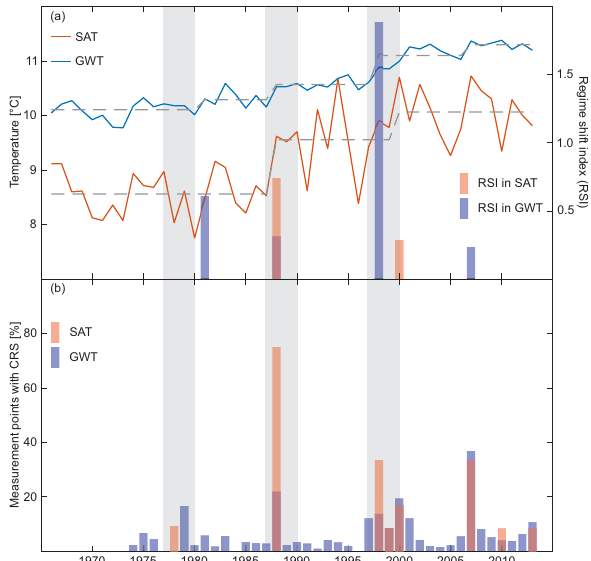
Figure 6. (a) Median groundwater temperature (blue) and surface air temperature (red) of all wells or rather weather stations as well as the corresponding CRS in the form of the regime shift index (RSI). (b) Percentage of measurement points in GWT (blue) and SAT (red) that show CRS in each year. The analysis of global temperatures data indicates a regime shift at the end of the 70s, the 80s and the 90s, which are shown here as grey